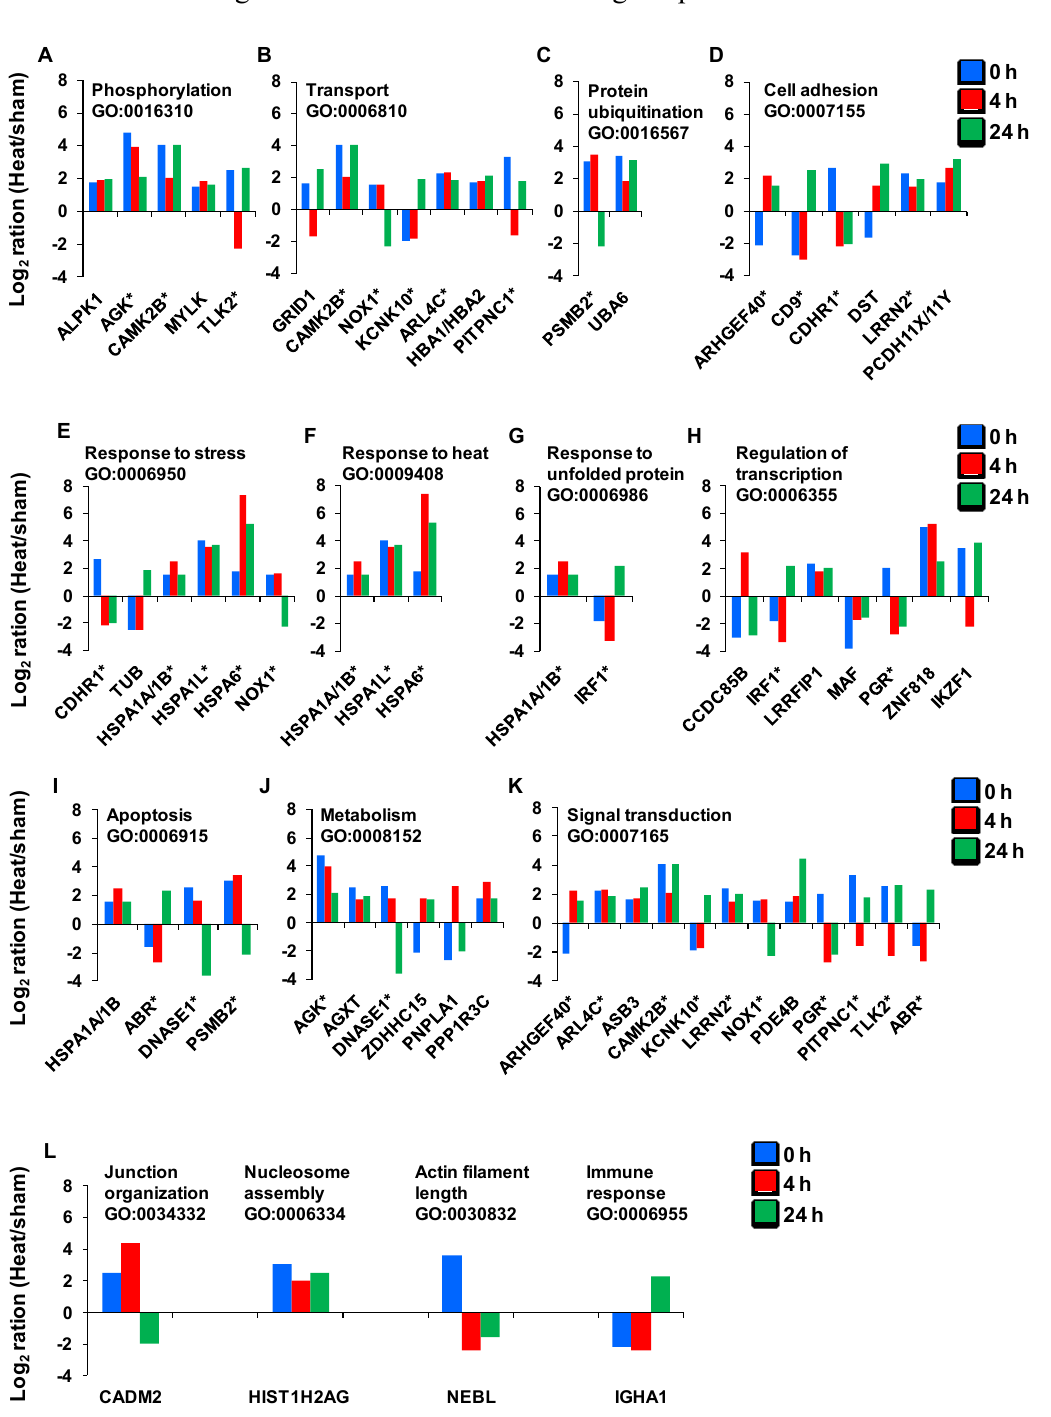
Figure 7. The temporal expression kinetics for the genes with known gene ontology (GO). Asterisks indicate the genes with more than one biological